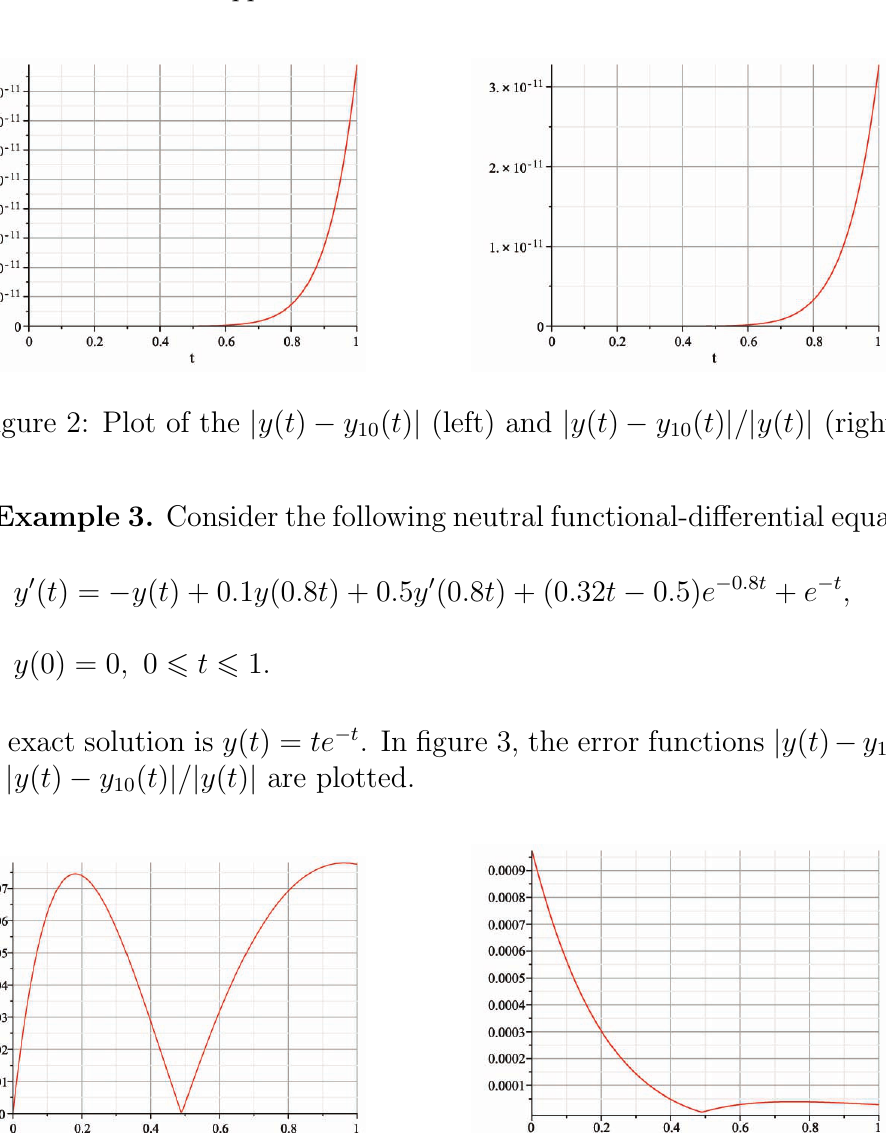
( t ) | (left) and | y ( t ) − y 10